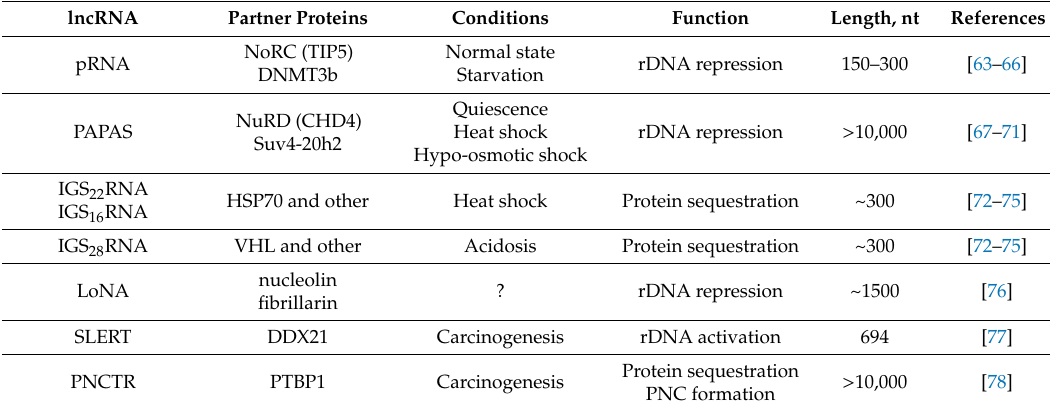
Table 1. lncRNAs in the nucleoli under stresses and di ff erent cell